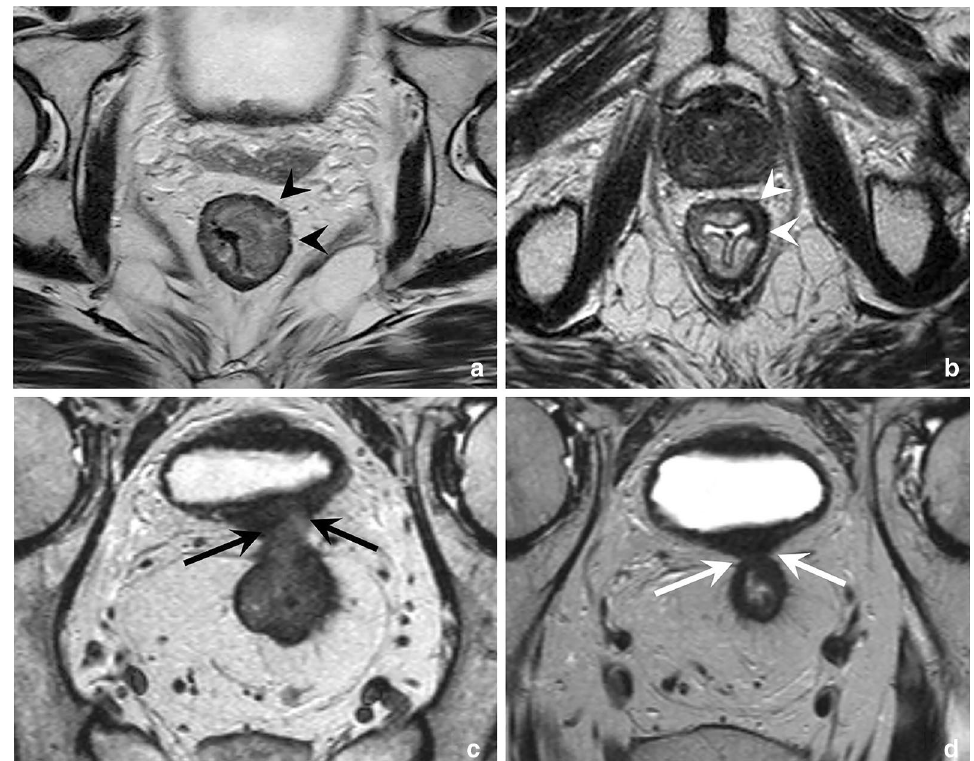
Fig. 13 Pre‑treatment and post‑chemoradiotherapy T2‑weighted MR images of 74‑year‑old male patient with a distal tumour primarily staged as cT1‑2 (upper row; a pre‑treatment, b post‑treatment, arrowheads indicating intact bowel wall around the tumour), and another 62 year old = = male patient with a more advanced cT4b tumour invading the dorsal bladder wall (bottom row, c pre‑treatment, d post‑treatment, arrows = = indicating invasion of the bladder). In both cases the tumour has decreased in size and become largely hypointense after CRT, indicating a fibrotic transformation (white arrowheads in b , white arrows in d ). If and to what extent viable residual tumour is present within the fibrosis is difficult to discern. The upper patient proved to be a complete responder (ycT0, followed by watch‑and‑wait with no signs of tumour regrowth for > 2 years). The bottom patient underwent resection showing a ypT3 tumour remnant at histopathology. The fibrosis invading and retracting the bladder wall (white arrows in d ) did not contain any vital residual tumour